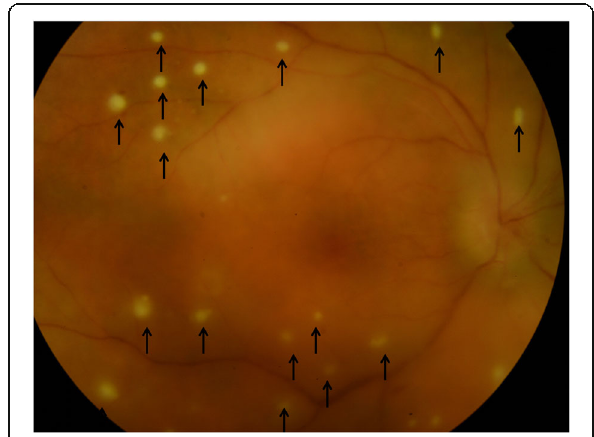
Fig. 2 Fundus color picture showing pre-retinal lesions overlying active retinitis (black arrows) associated with vitritis